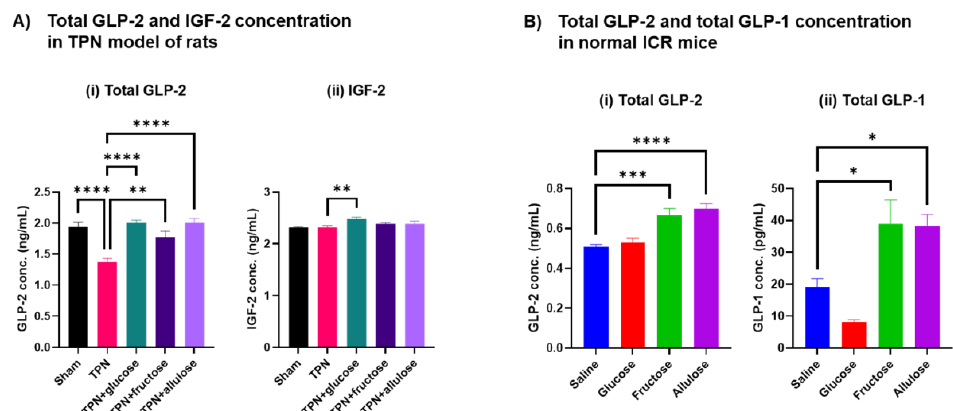
Figure 8. Concentration of GLP-2, IGF-2, and GLP-1 in plasma of peripheral blood in TPN model of rats and portal vein blood in normal mice. Measurement of total GLP-2 by EIA kit, IGF-2 by ELISA kit and total GLP-1 by ELISA kit in plasma. ( A ) Total GLP-2 ( i ) and IGF-2 ( ii ) concentration in plasma of peripheral blood in TPN model of rats. Values indicate mean ± SEM ( n = 4). Asterisks indicate significant differences tested using the ANOVA-Dunnett’s multiple comparisons test (vs. TPN group, **** p < 0.0001, *** p < 0.001, ** p < 0.01, * p < 0.05). ( B ) Total GLP-2 ( i ) and total GLP-1 ( ii ) concentration in plasma of portal vein blood in normal mice. Values indicate mean ± SEM ( n = 6). Asterisks indicate significant differences tested using the ANOVA-Dunnett’s multiple comparisons test (vs. saline group, **** p < 0.0001, *** p < 0.001, * p < 0.05).